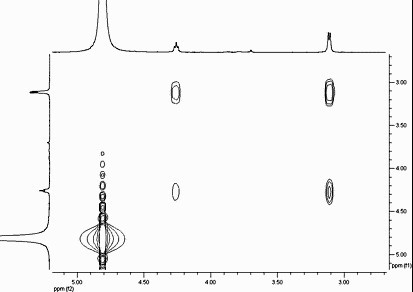
2D COSY NMR spectrum (400 MHz, D2O) of aspartic acid-coated TiO2 nanoparticles.